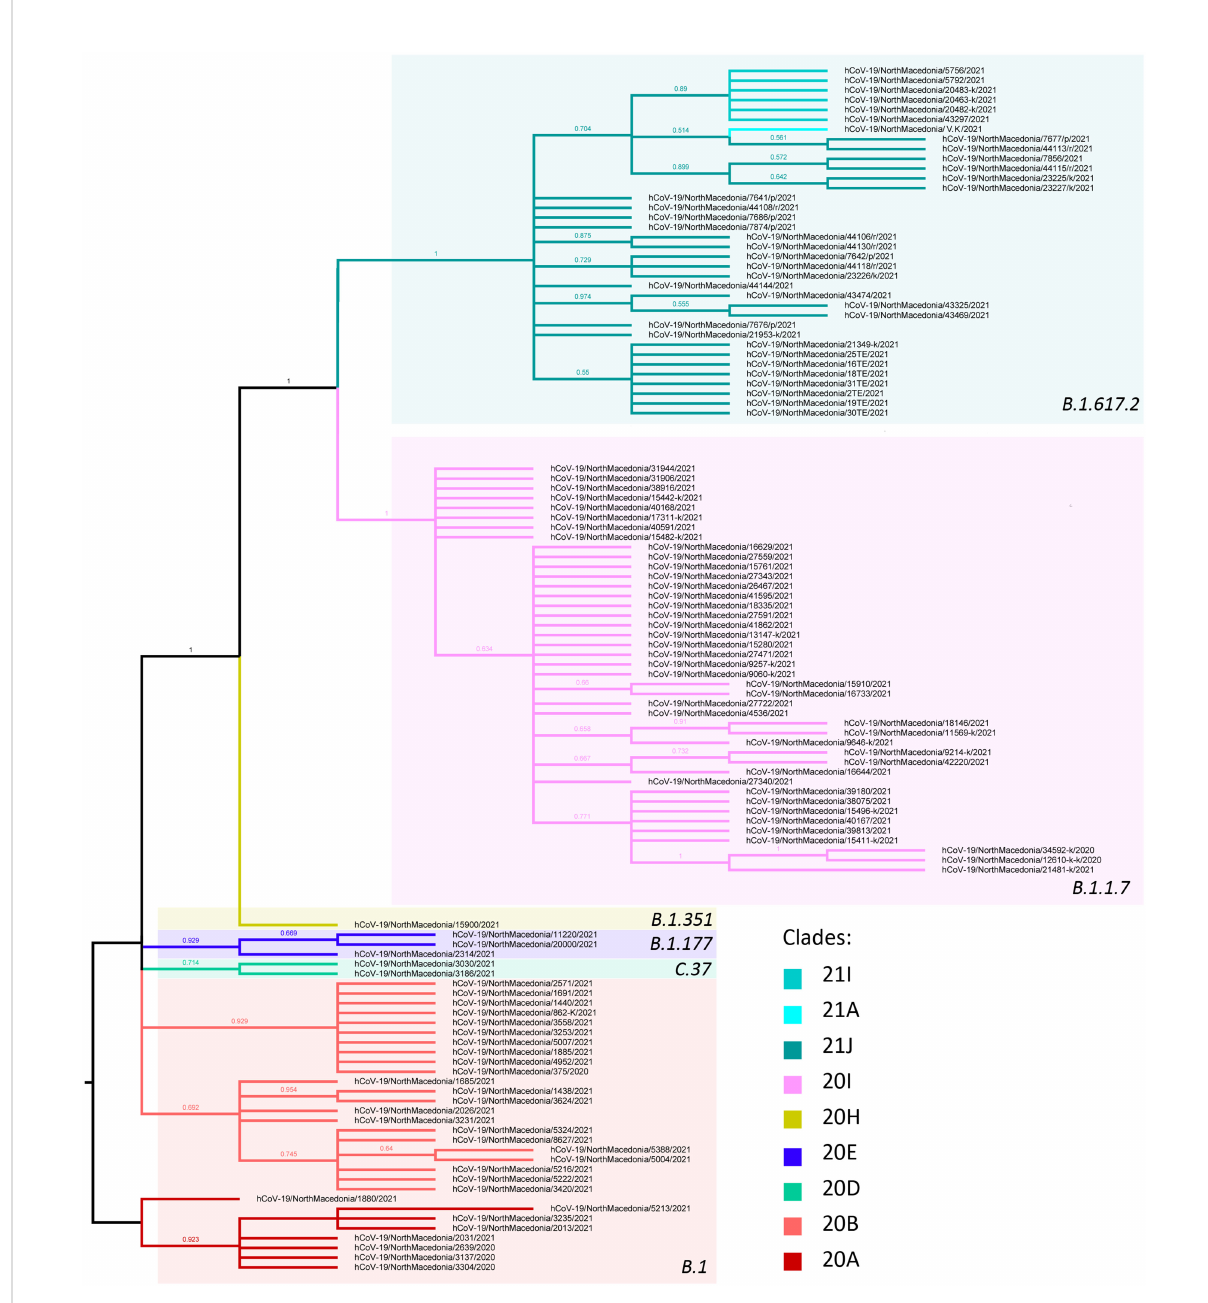
FIGURE 6 Phylogenetic tree of Macedonian sequenced strains of SARS-CoV-2. Lineages are separated into different color boxes, colors representing different clades are designated in fi gure